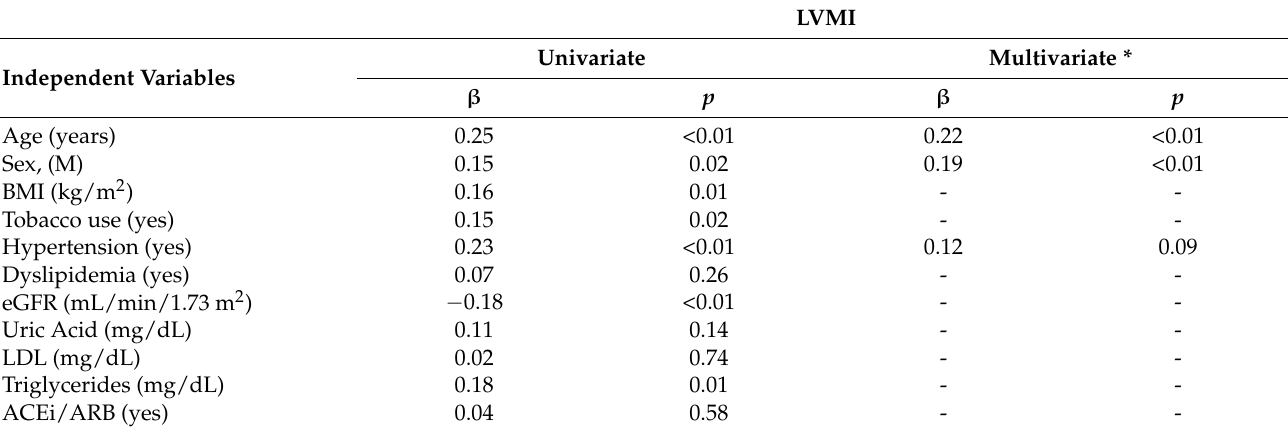
Table 3. Possible determinants of LVMI using linear